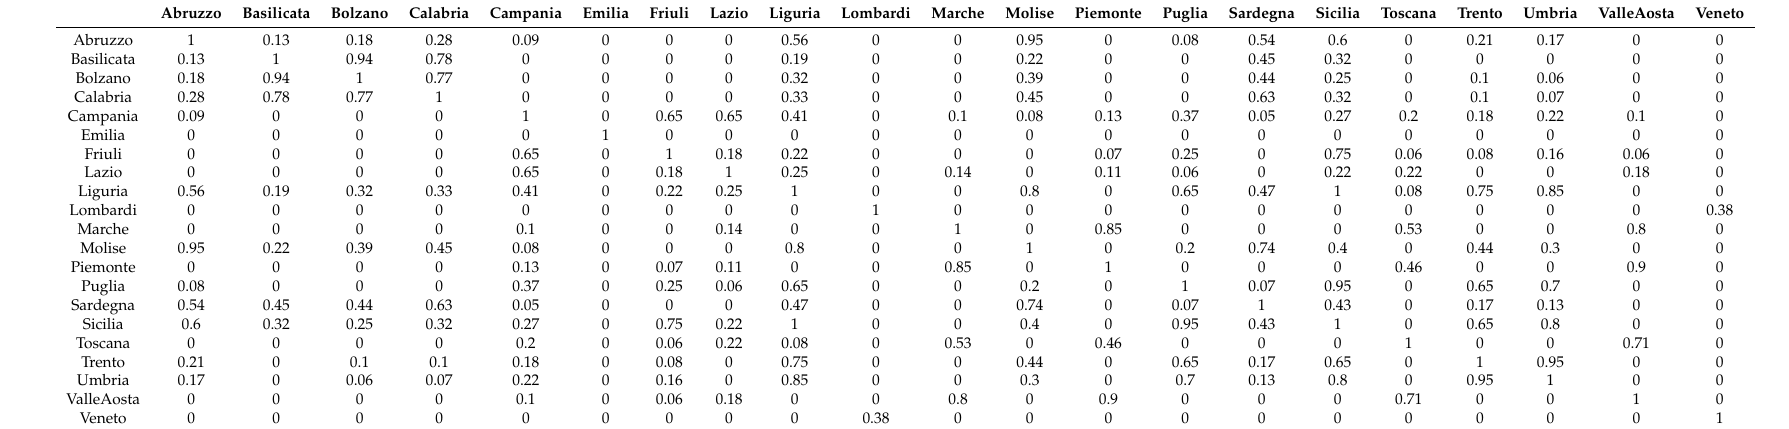
Table A33. Similarity values of New Currently Positive network in the second week.